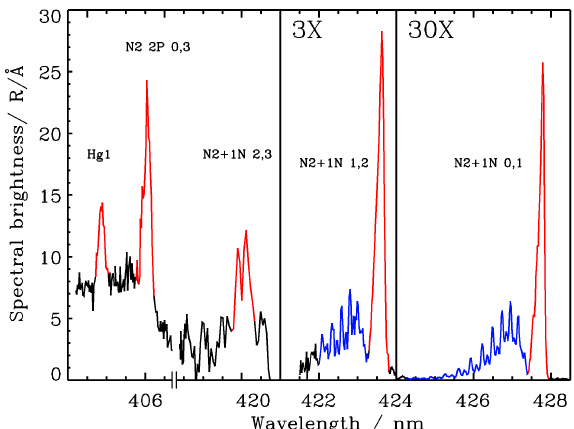
Fig. 2. Sample data from the HiTIES spectrograph using a 5-band mosaic filter (excluding the H α and H β lines). The highlighted spectral features here correspond in increasing wavelength to HgI (red) overlaid from cloudy data, N 2 2P (0,3) (red), N + (red), N + 1N R of (1,2) (blue) P of (1,2) (red) and N + 2 (0,1) (blue) and P of (0,1)